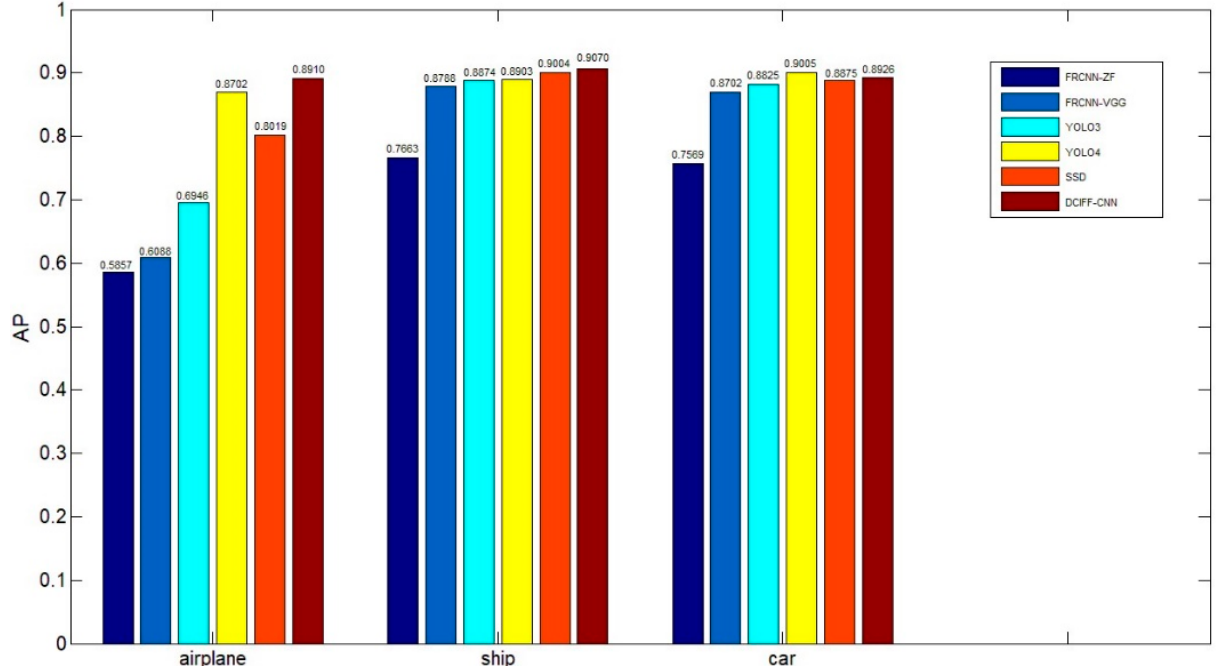
Figure 13. The average precision of target detection on the collected dataset.